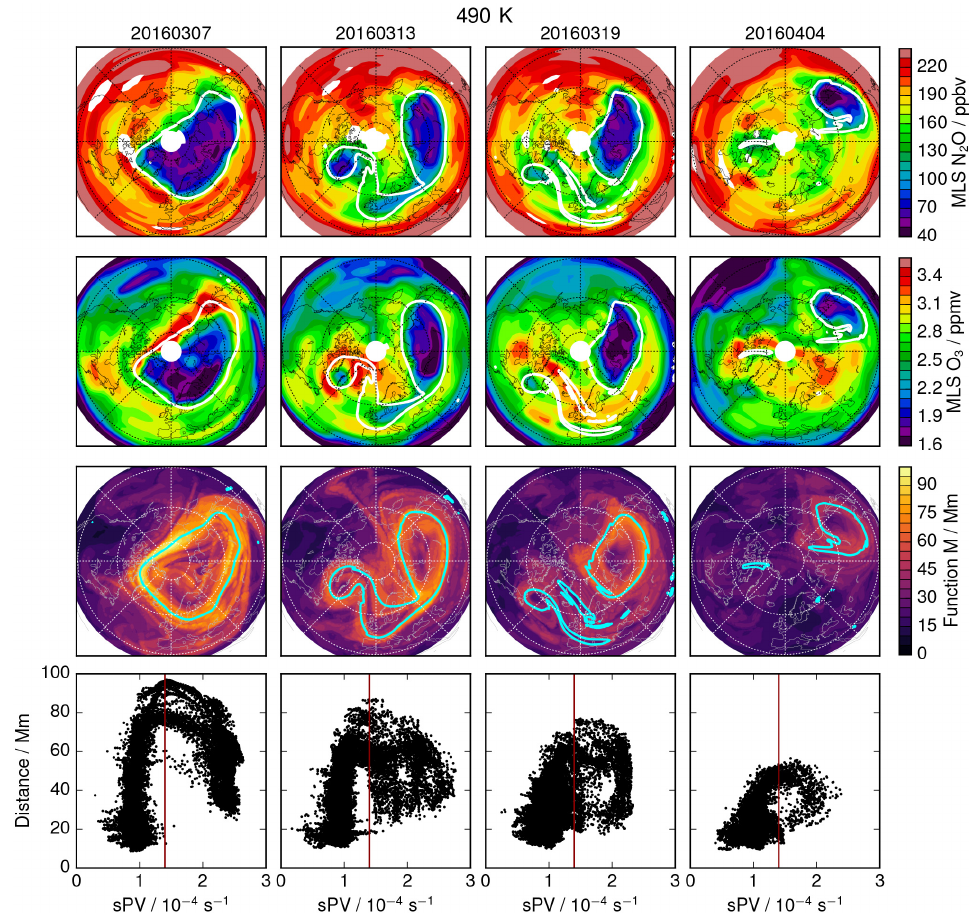
Figure 10. As in Fig. 9, but at 490K, and showing MLS N 2 O and O 3 (in first and second rows,